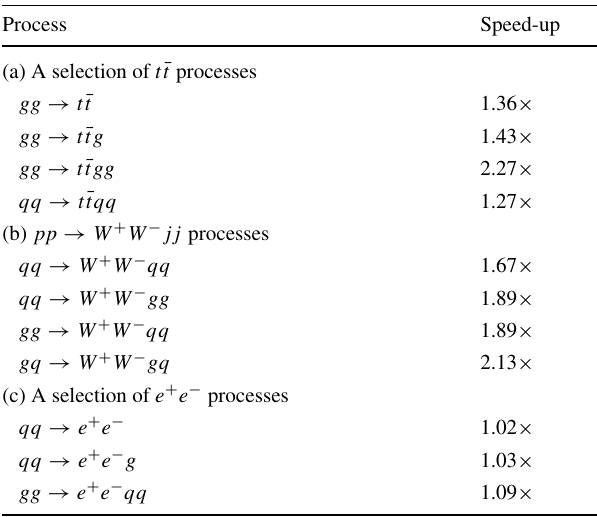
Table 3 The factor speed-up of madevent as a result of using helicity recycling for a selection of SM processes. Here q ∈ { u , d , c , s } . One can see two general principles at play. Firstly, the more diagrams a process has and the more complicated those diagrams are, the bigger the speed increase. For example, see the effect of adding more gluons in (a). Secondly, the more helicity combinations we filter away, the